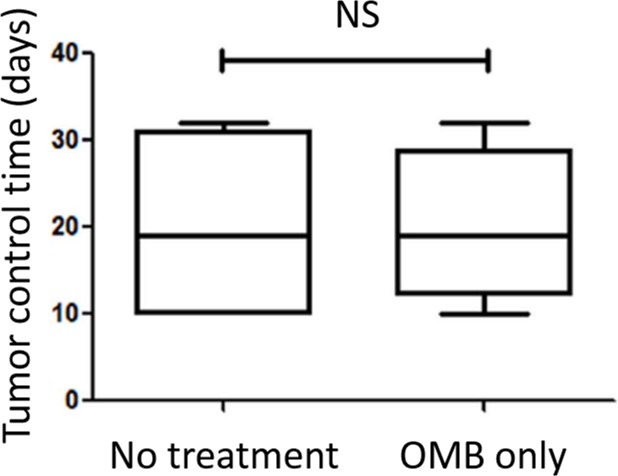
A single oxygen microbubble administration alone does not influence tumor control.No significant difference was found between the no treatment and oxygen microbubble group in the absence of any radiotherapy (n = 4 per group). Box-and-whisker plots represent all data from the No treatment and OMB alone controls.